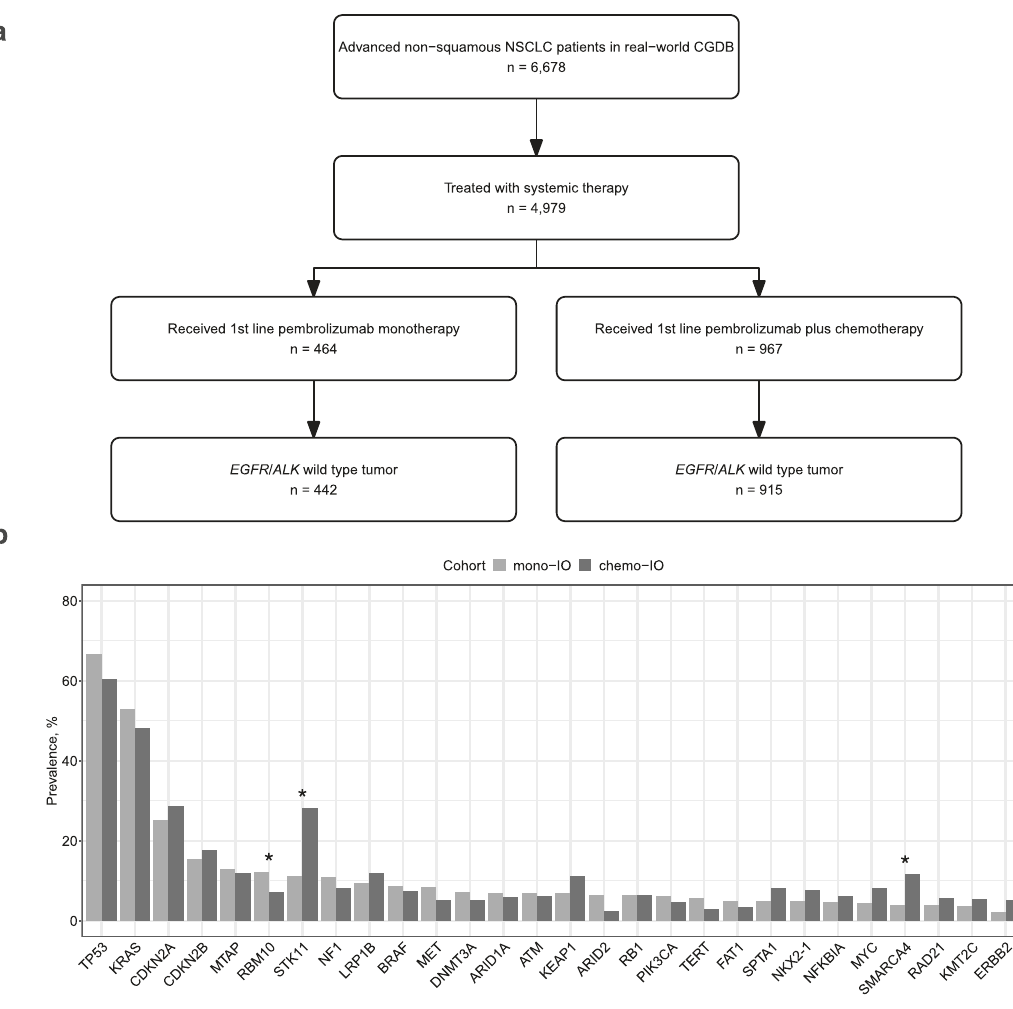
Fig. 1 Clinical cohort selection and genomic characterization. a Flowchart depicting clinical cohort selection. The NSCLC CGDB included 6678 patients who had a medical record-con fi rmed diagnosis of advanced non-squamous NSCLC, received care within the Flatiron Health network between January 2011 and December 2020, and underwent tissue-based CGP by Foundation Medicine during their cancer care. Among these patients, 4979 had documentation of initiation of at least one line of systemic therapy after advanced diagnosis. This study was limited to advanced non-squamous NSCLC patients whose tumor did not harbor an EGFR short variant or ALK rearrangement, and received fi rst-line treatment with pembrolizumab monotherapy or fi rst-line treatment with pembrolizumab plus pemetrexed and platinum-based chemotherapy. b Bar chart of the prevalence of gene alterations by treatment cohort. *FDR p -value <